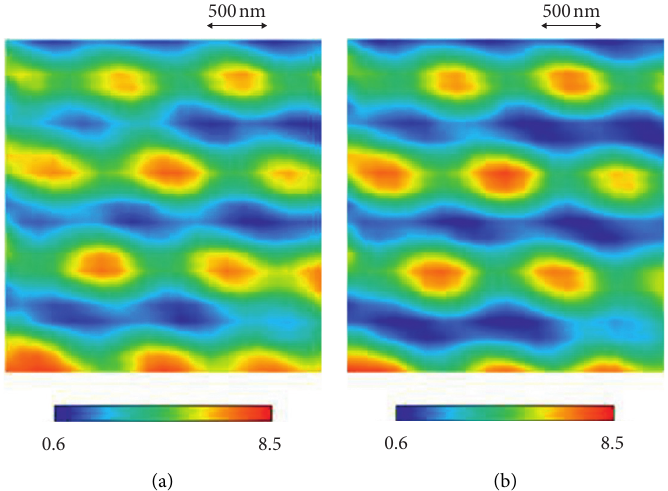
Figure 5: Tomographic images of two dimensionally arranged PE-dye-doped polystyrene with two types of microscopes: (a) with conventional confocal microscope and (b) with DFWM confocal microscope.